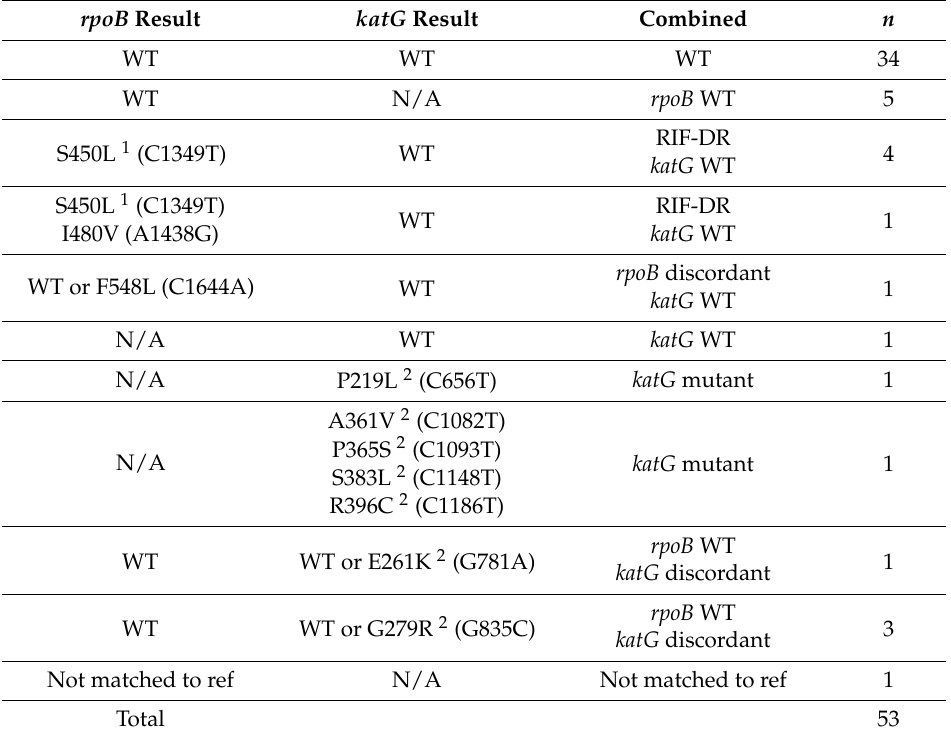
Table 4. Summary of sequencing results for the rpoB and katG amplicons, including nucleotide and codon mutations. rpoB Result katG Result